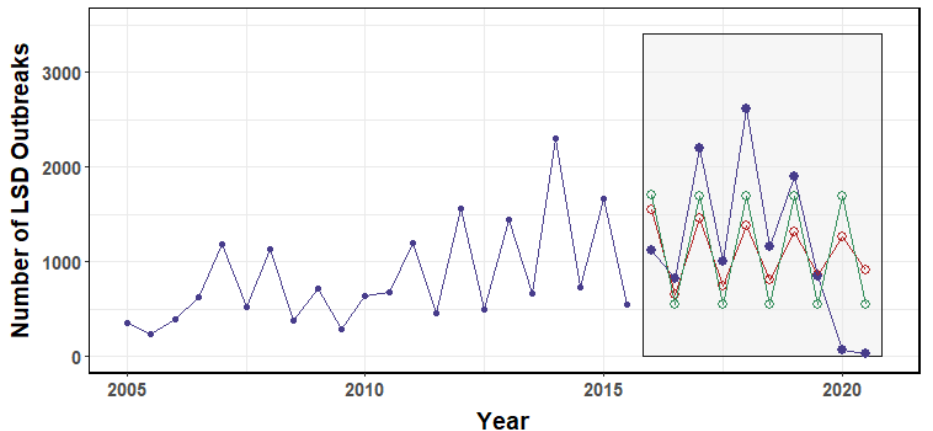
Figure 9 . Report on the LSD outbreaks in Africa. The forecast models were built with data from 2005 to 2015, and validated with data from 2016 to 2022. The gray box represents the comparison between the forecasted LSD outbreak values obtained by the ARIMA (red circles) and NNAR (green circles) models and the actual outbreak values (blue dots).